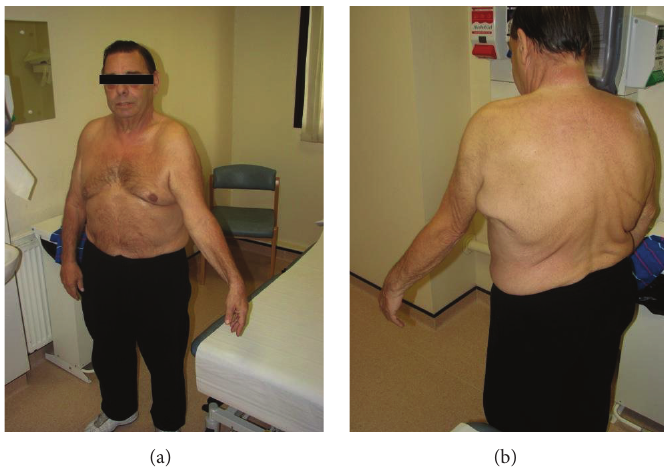
Figure 1: Patient on presentation, with fixed external rotation deformity of the left upper limb.